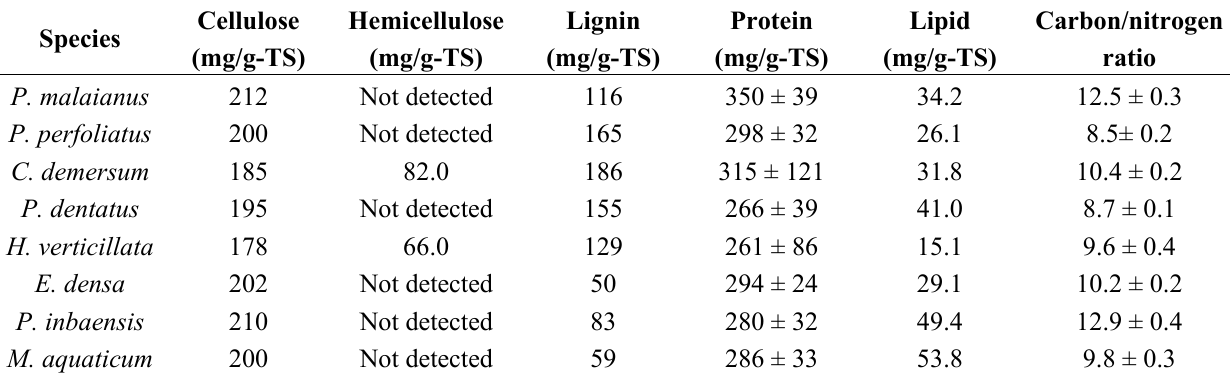
Table 1. Characteristics and composition of the submerged macrophytes.